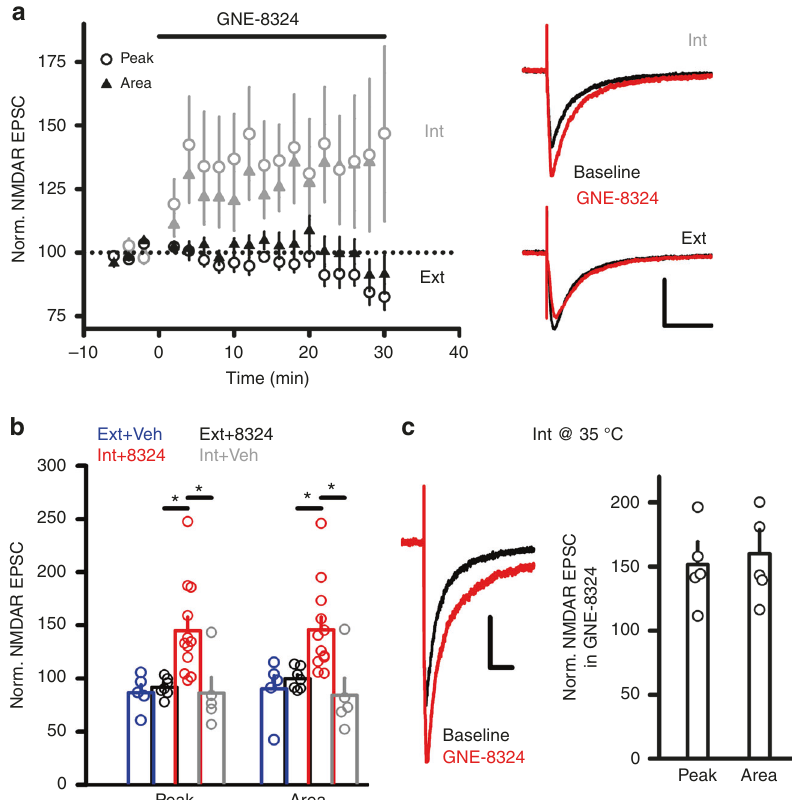
Fig. 1 Characterization of potentiation of NMDAR EPSCs by GNE-8324. a Effect of GNE-8324 on NMDAR EPSCs in inhibitory neurons (Int, gray) and excitatory neurons (Ext, black). Sample traces of NMDAR EPSCs in inhibitory neurons (Int, upper) and excitatory neurons (Ext, lower) before and after application of GNE-8324. Scale bars, 50 pA/100 ms. b Quanti fi cation of potentiation shown in a . N = 5 (Ext + Veh), 7 (Ext + GNE-8324), 12 (Int + GNE- 8324), and 5 (Int + Veh). * P < 0.05, one-way ANOVA with Tukey's correction. c GNE-8324 potentiation in inhibitory neurons also occurred at 35 °C. Left: Sample traces showing potentiation by GNE-8324. Scale bars, 40 pA/100ms. Right: Population data. Error bars represent